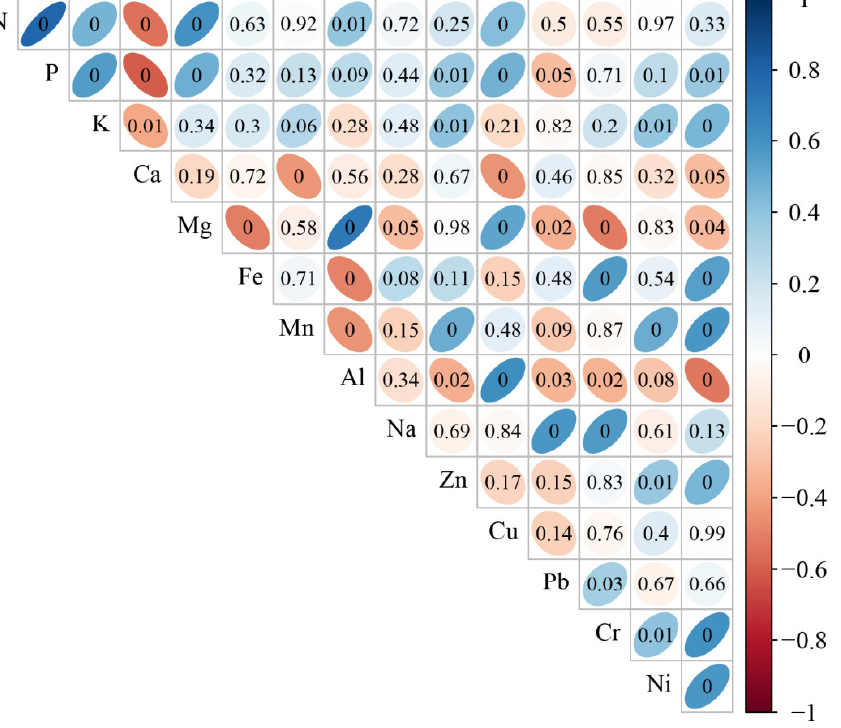
Figure 3. The correlogram (Pearson rank correlation coefficients Rs from − 1 to 1) for all pairs of elements examined for J. communis populations. Blue color represents positive and red color represents negative correlations. Color intensity indicates the strength of correlation, so the stronger the correlation, the darker the color. Correlation numbers inside colored figures indicate the level of significance: thin ellipsoid figures show significant ( p < 0.05) correlations, while figures towards spherical shape showinsignificant correlations. N, Ca, P, K, and Mg (macroelements), Mn, Fe, Na,